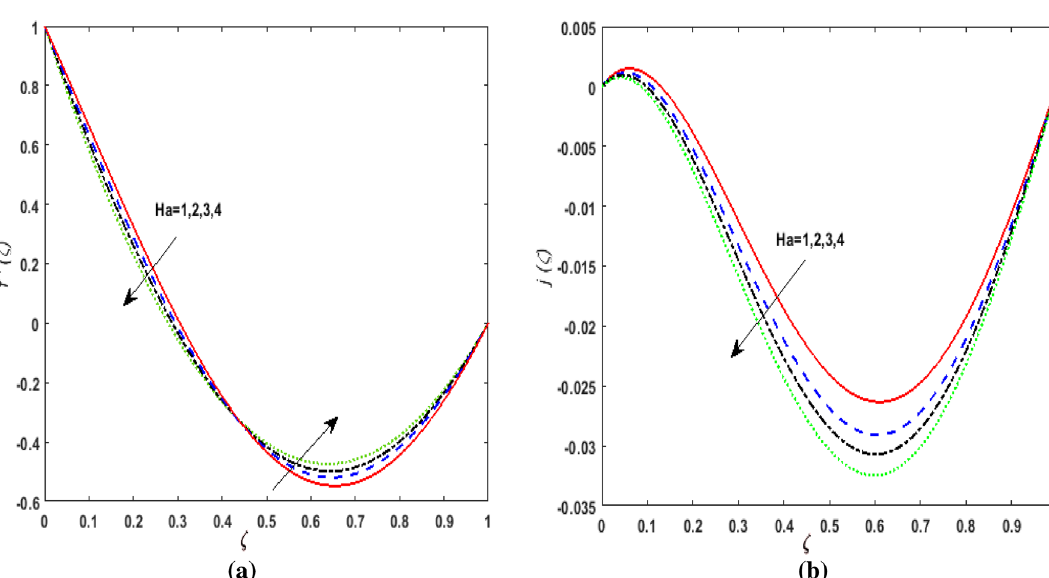
Figure 4. ( a ) Effect of magnetic parameter Ha on velocity f ′ (ζ) . ( b ) Effect of magnetic parameter Ha on velocity j (ζ)